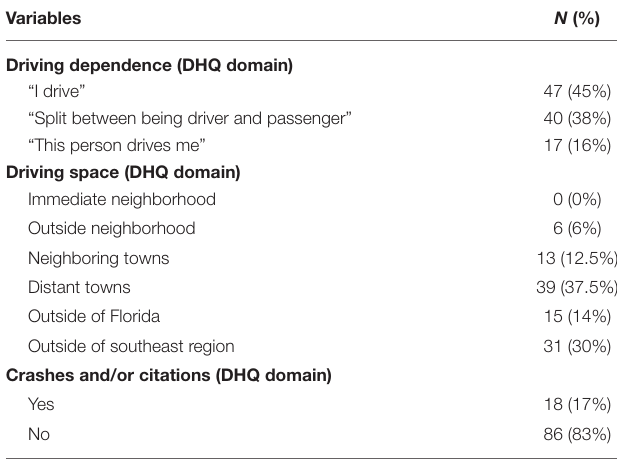
TABLE 3 | Indicators of categorical independent variables: Driving dependence, driving space, and crashes and/or citations ( N = 104). Variables